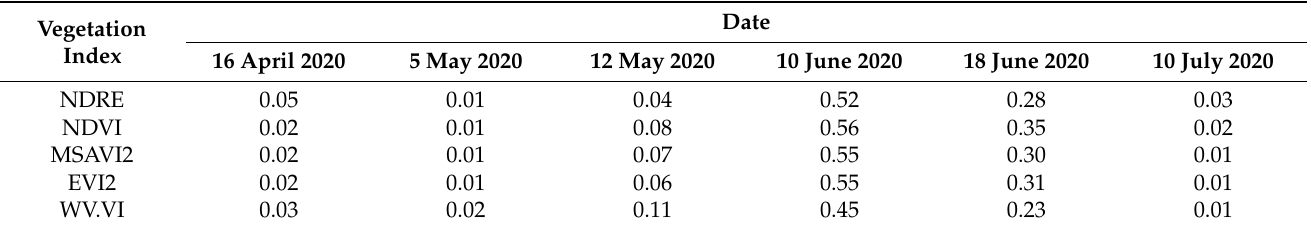
Table 13. Coefficient of determination (R 2 ) of the relationship between the vegetation indexes and the resistivity map during all growing